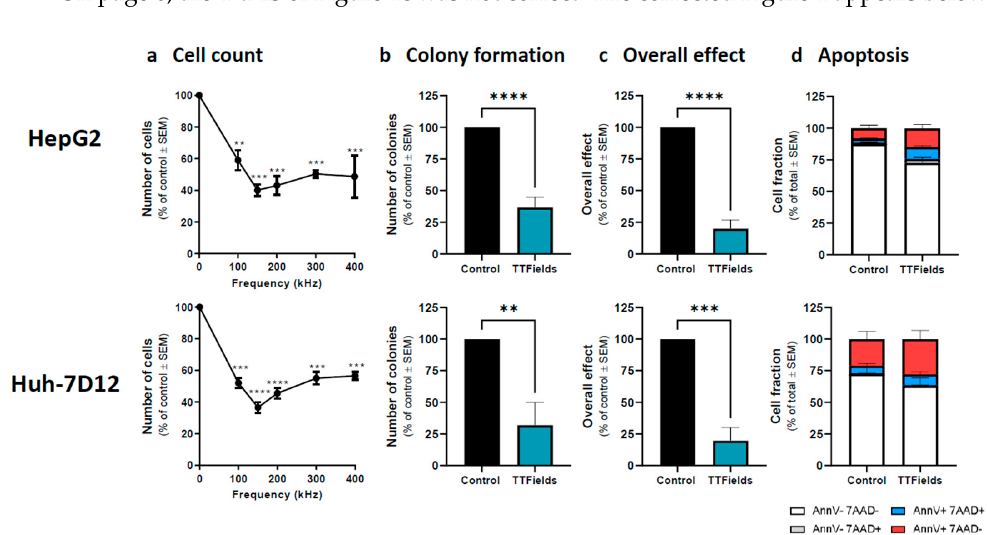
Figure 1. Efficacy of TTFields for treatment of HCC cells. HepG2 and Huh-7D12 cells were treated with TTFields (1.0 and 1.7 V/cm RMS, respectively) for 72 h. Cell counts were determined following treatment with TTFields at a frequency range of 100–400 kHz ( a ). Values are mean (N ≥ 3) ± SEM. ** p < 0.01, *** p < 0.001, and **** p < 0.0001 relative to control; one-way ANOVA. Clonogenicity ( b ), overall effect ( c ), and apoptosis ( d ) were examined for treatment of the cells with 150 kHz TTFields. Values are mean ± SEM. ** p < 0.01, *** p < 0.001, and **** p < 0.0001 relative to control; For apoptosis assay live cells: p < 0.05 for HepG2 and p = 0.14 for Huh-7D12 relative to control; Student’s t -test. ANOVA = analysis of variance; HCC = hepatocellular carcinoma; RMS = root mean square; SEM = standard error of the mean; TTFields = Tumor Treating Fields. On page 7, the color coding was missing in Figure 2. The corrected Figure 2 appears